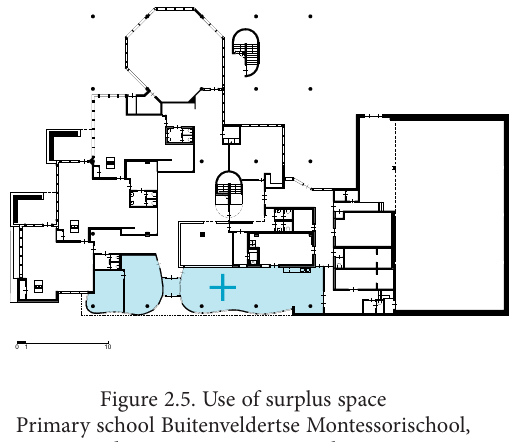
Figure 2.5. Use of surplus space Primary school Buitenveldertse Montessorischool, Amsterdam, Berger Barnett Architects, 2010 Coloured: utilized surplus space